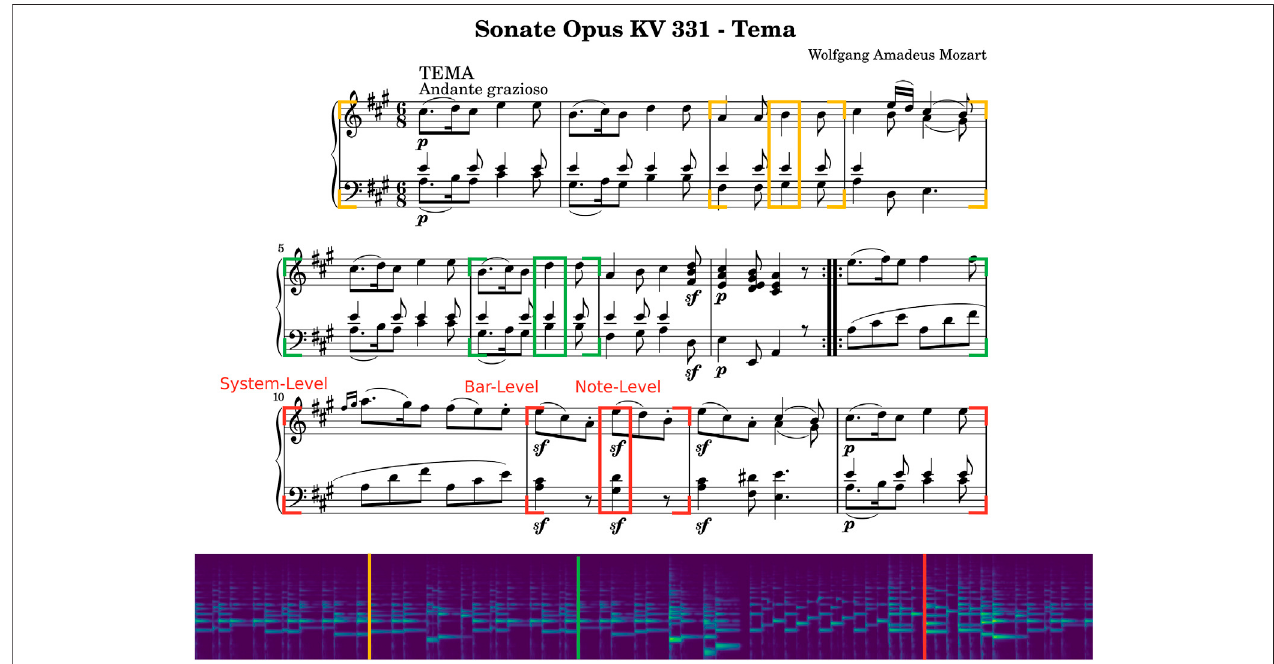
FIGURE 3 | Data Annotation with three different granularities: system-, bar-, and note-level. For each frame in the audio, the model has to predict the most likely system, bar and note position in the sheet image matching the audio up until the current point in time. The colored bars in the spectrogram mark the onset times in the audio corresponding to the (note-level) ground truth bounding boxes in the sheet